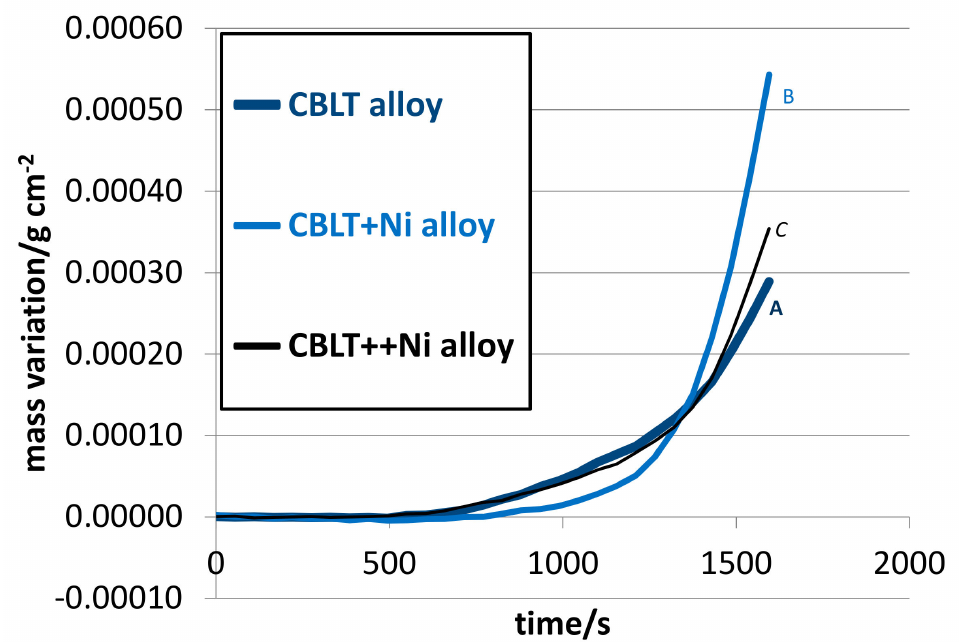
Figure 5. The heating parts of the thermogravimetry (TG) curves (plotted as mass gain versus time, after correction from the consequence of the air density variation); A: the CBLT alloy; B: the CBLT+Ni alloy; C: the CBLT++Ni